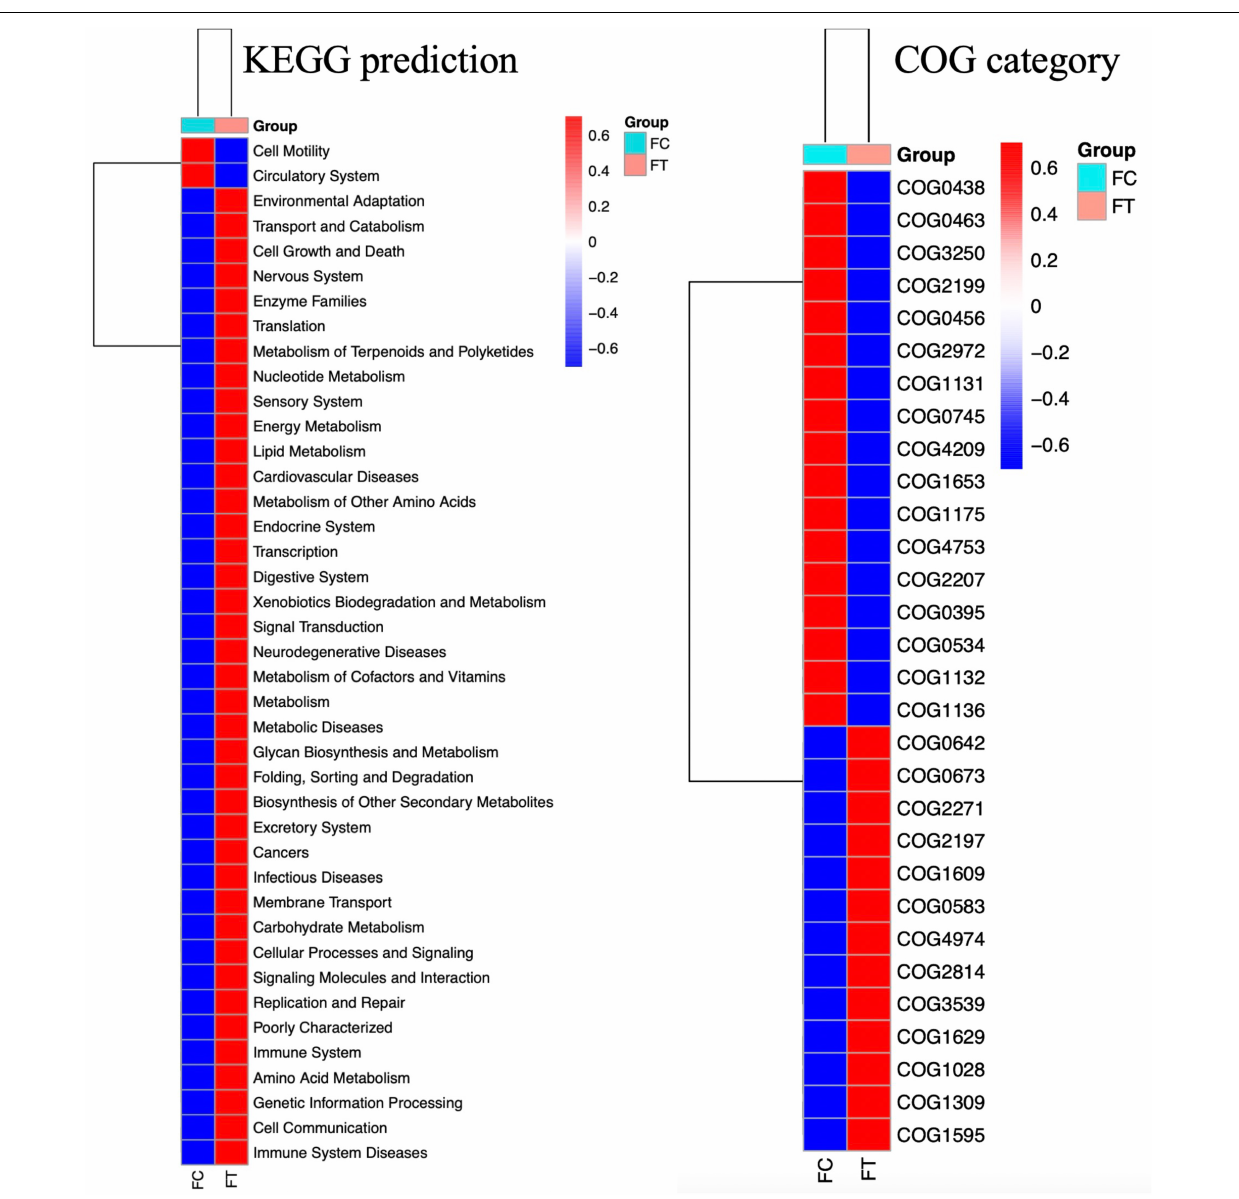
FIGURE 5 | Heat map showing the predicted KEGG and COG functional pathways differing in the gut microbiota of the control females (FC) and the antibiotic-treated females (FT) inferred from 16S rRNA gene sequences using PICRUSt. Red legends indicate the mean of significantly enriched pathways and blue the depleted pathways across all gut samples of mice ( P <